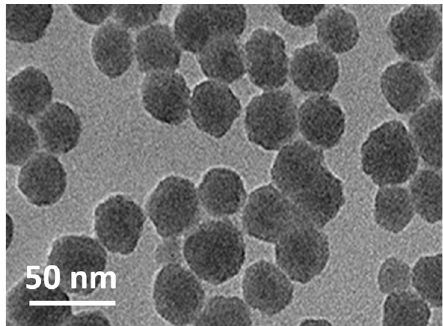
Figure 2. TEM image of silica nanoparticle.